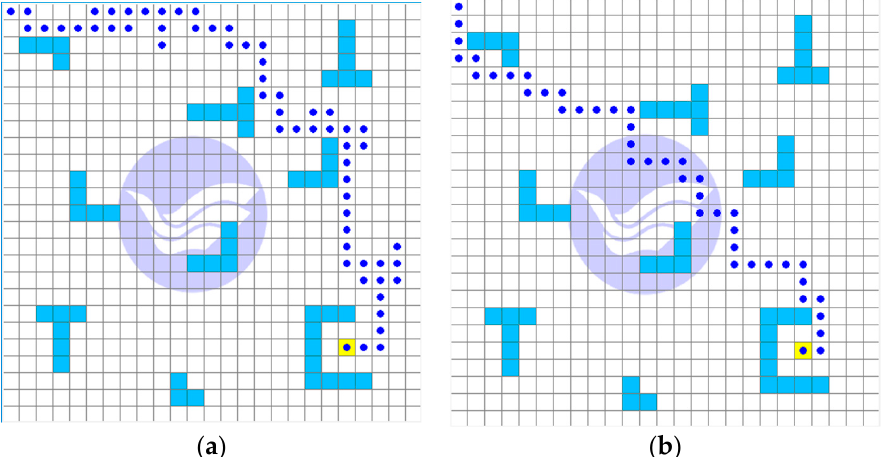
Figure 25. The experiment in Environment 1: ( a ) SARSA algorithm, ( b ) Q-learning algorithm.